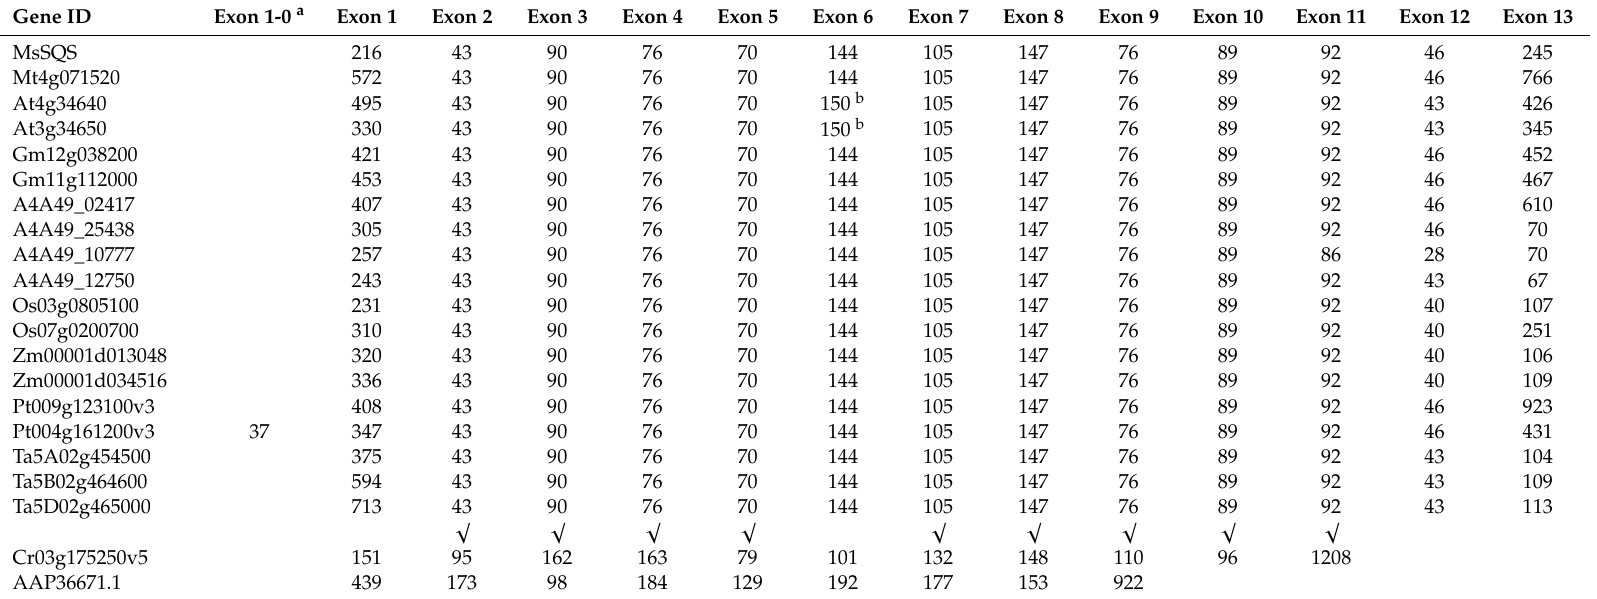
Table 1. Comparison of the exon / intron composition of SQS in the indicated